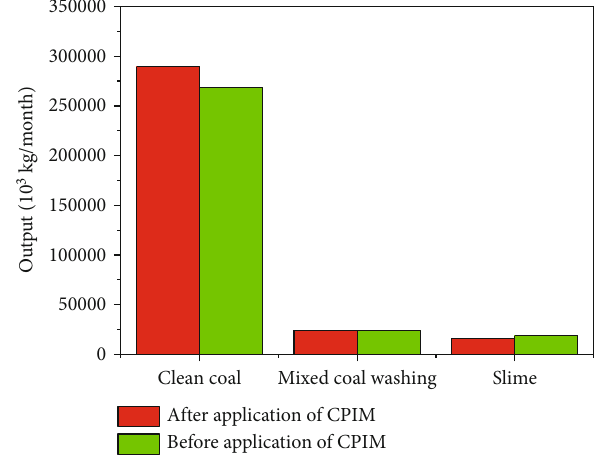
Figure 11: Comparison of the output per month between and after application of Coal Processing Information Model